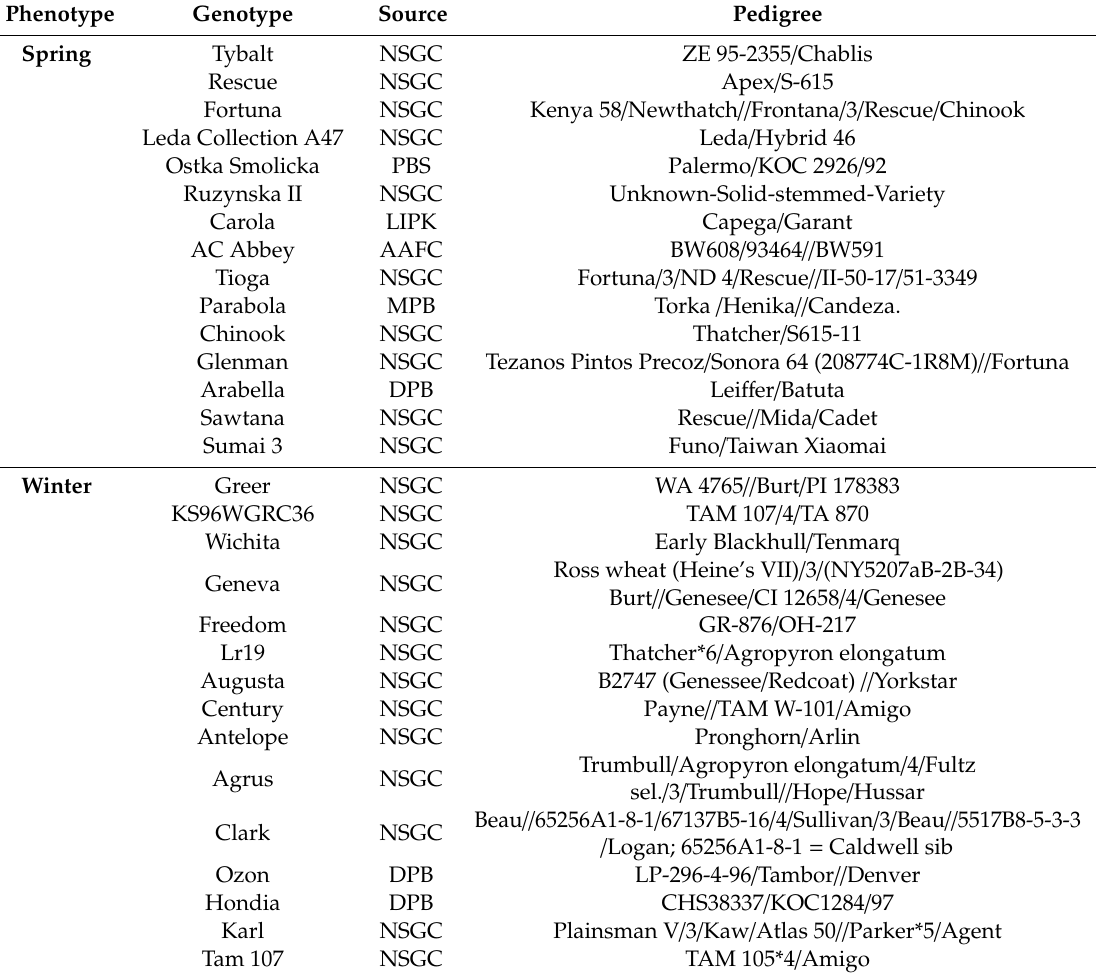
Table 3. The origin and pedigree of the spring and winter wheat